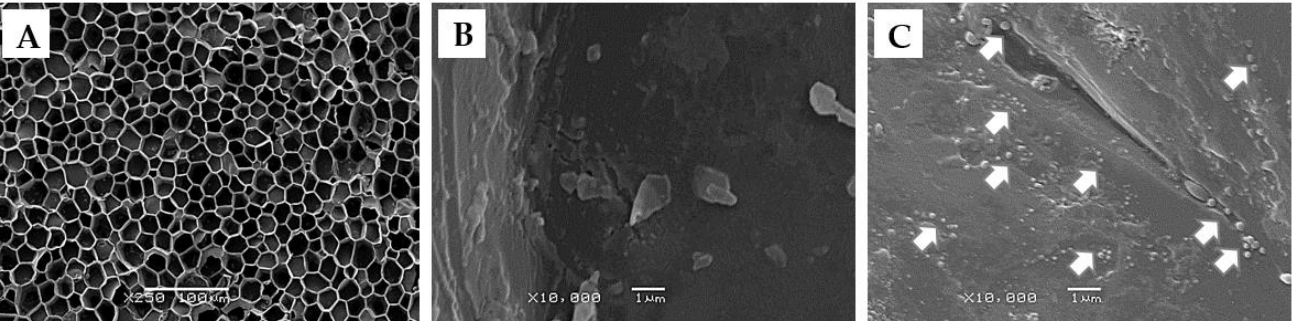
Figure 3. SEM microphotographs showing the ultrastructure of unmodified cork at two magnifica- tions ( A ) = x250 and ( B ) = x10,000), and the ultrastructure of the AgLNP coated-cork ( C ). Note the presence of circular nanoparticles attached to the surface of the cork composite material in C (white arrows).